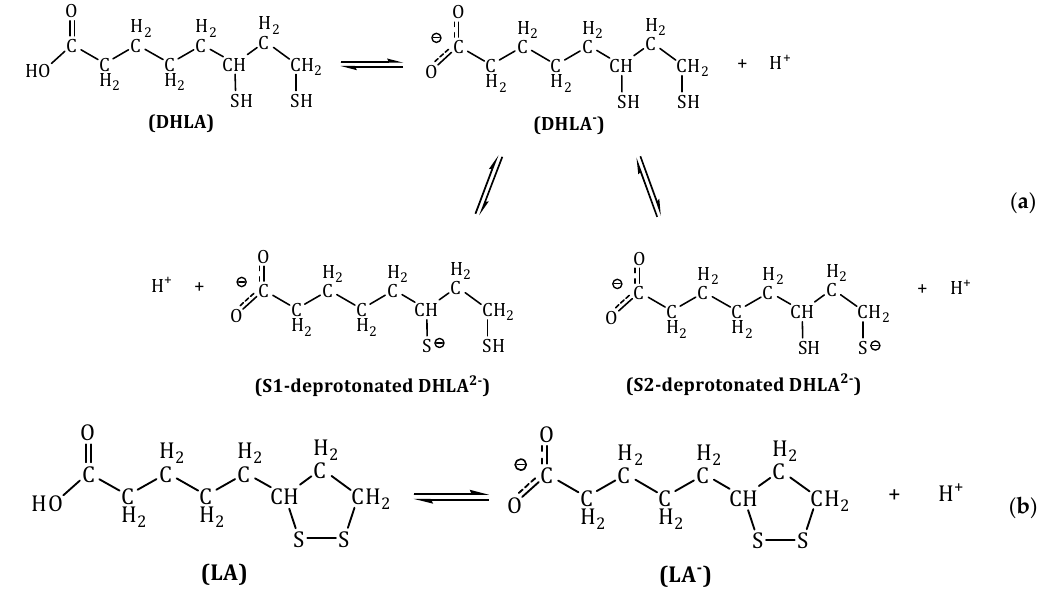
Figure 1. Acid-base equilibria involving dihydrolipoic (DHLA, ( a )) and lipoic (LA, ( b )) acids.